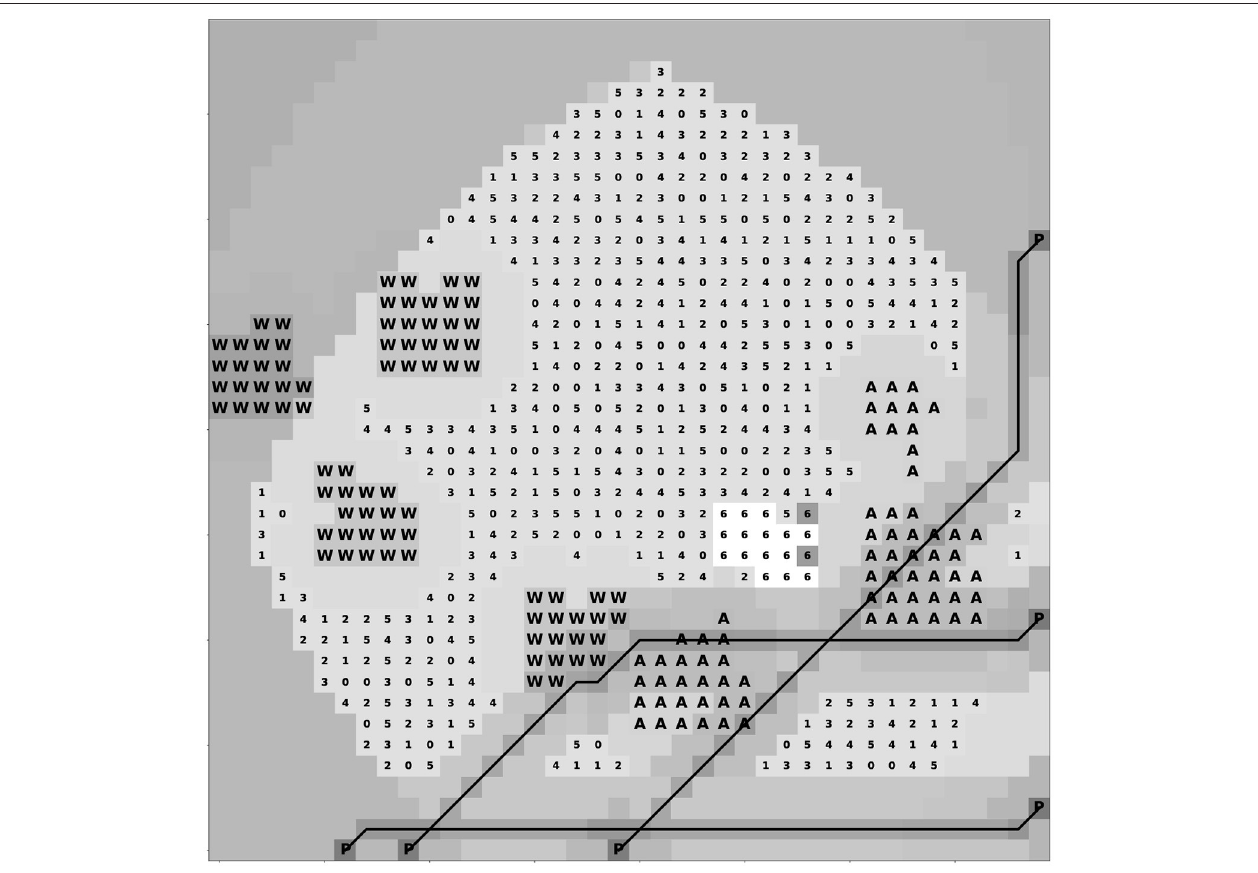
FIGURE 8 | The sample validity map with one very compact area.